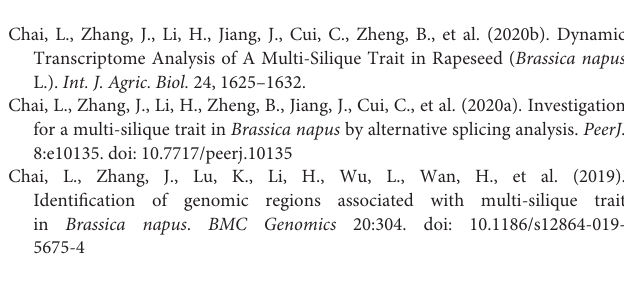
Supplementary Table 2 | Line-specific expressed genes from Xindu. Supplementary Table 3 | Line-specific expressed genes from